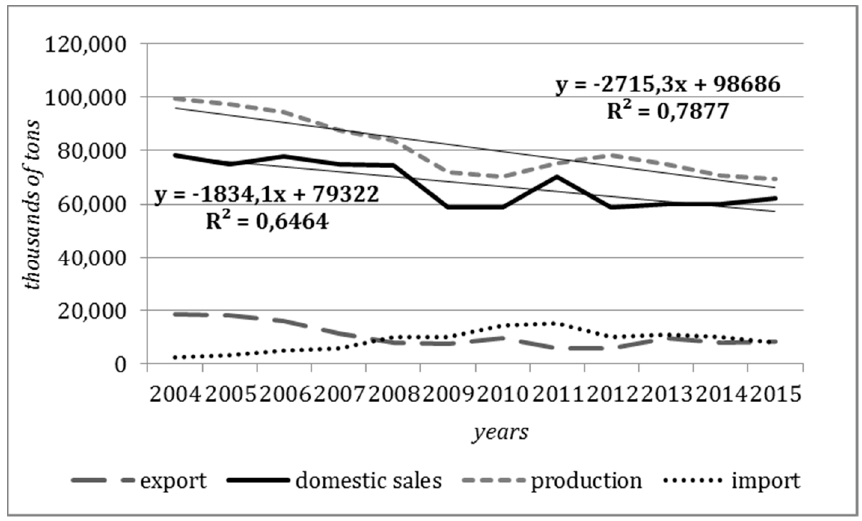
Figure 1. Production, domestic sales, imports and exports of hard coal in Poland over the period of 2004 to 2015 (in thousands of tons). Source: own work.